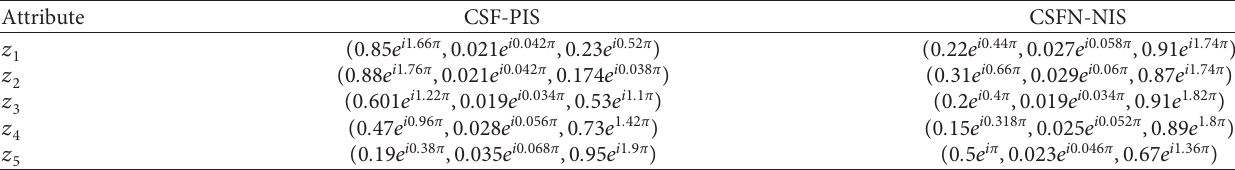
Table 48: Tabular representation of CSF-PIS and CSF-NIS.